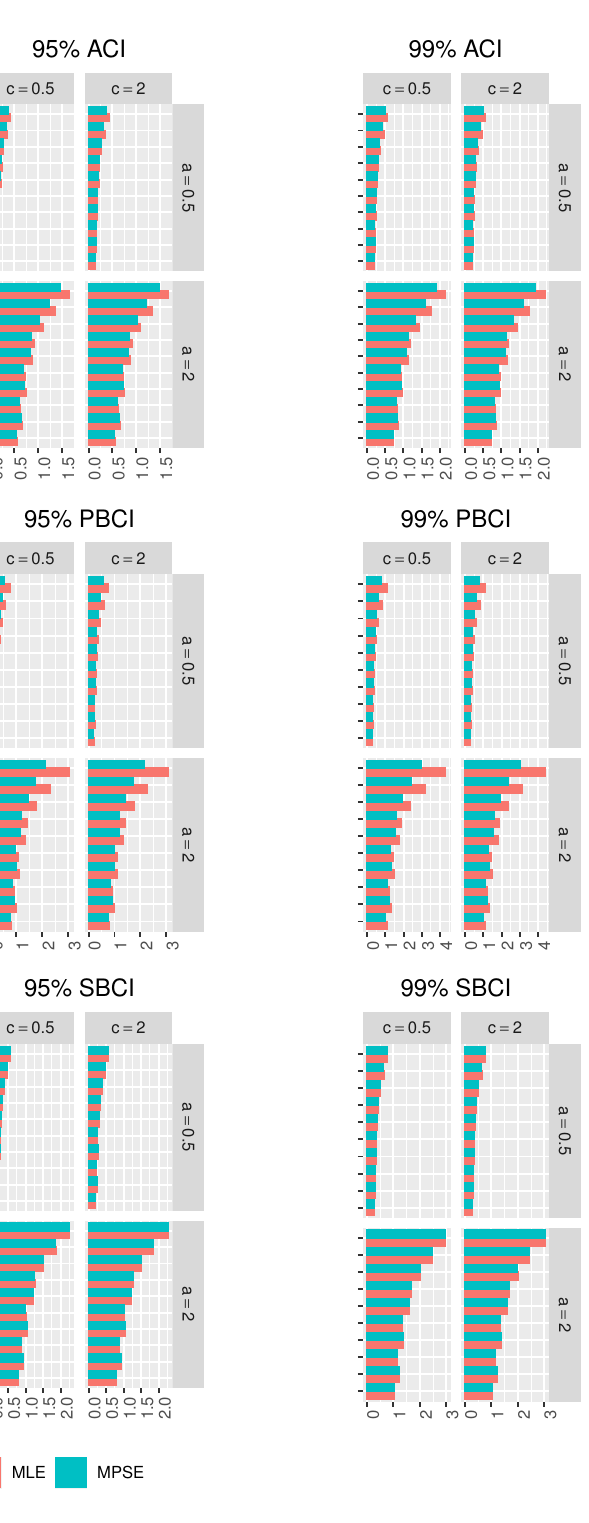
Figure 5. Simulated Lens of different CIs of a